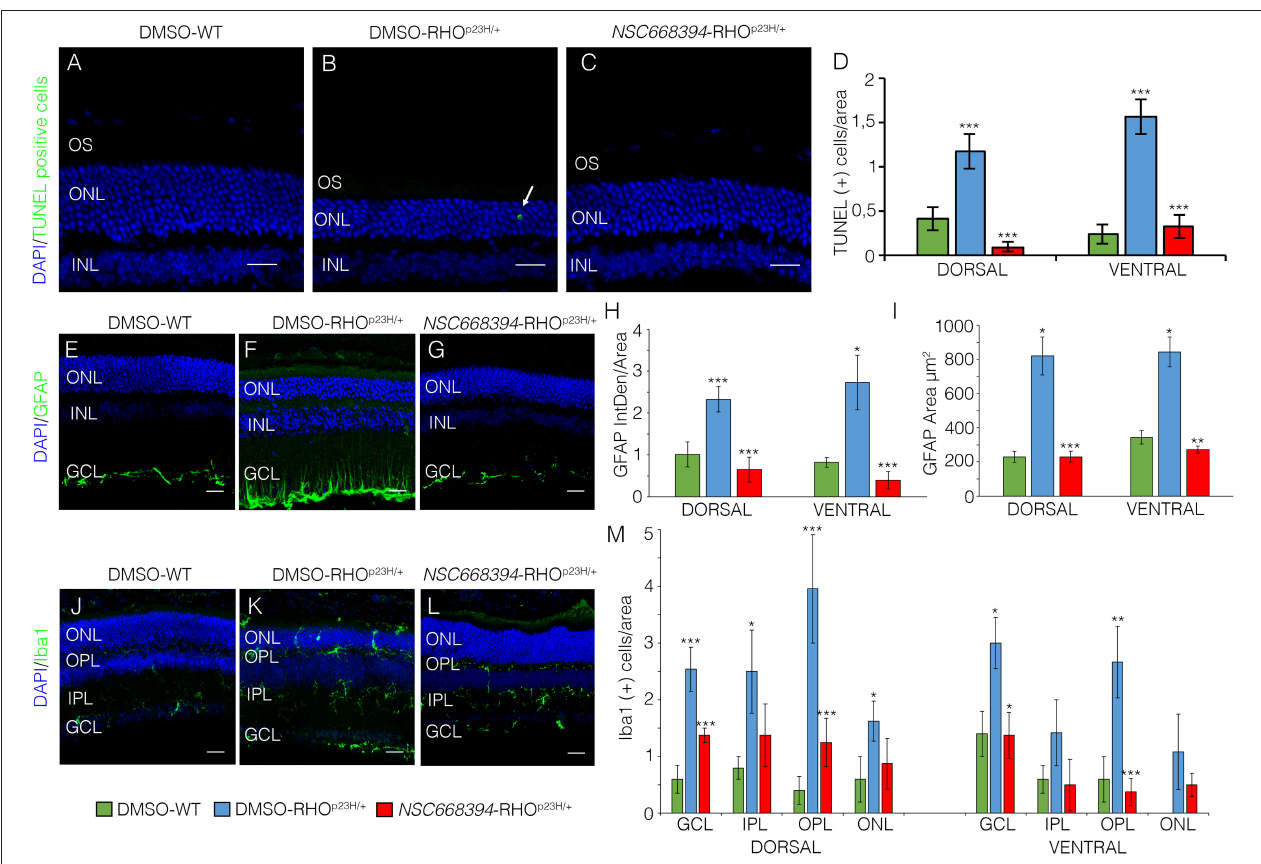
FIGURE 3 | The NSC668394 -treated RHO P23H / + mice display a reduction in retinal cell death, microglia and inflammation. Representative images of DMSO-treated WT (A) , DMSO-treated RHO P23H / + (B) and NSC668394 -treated RHO P23H / + (C) retinas of 2 months of age stained with TUNEL-fluorescein. Positive cells are indicated with white arrows. Nuclei are counterstained with DAPI (blue). At least n = 4 mice per group. Scale bar 20 µ m. (D) Graph shows the number of TUNEL positive cells from the dorsal and ventral retina of DMSO-treated WT, DMSO-treated RHO P23H / + and NSC668394 -treated RHO P23H / + mice at 2 months of age. Error bars represent SEM. Representative images of DMSO-treated WT (E) , DMSO-treated RHO P23H / + (F) and NSC668394 -treated RHO P23H / + (G) retinas of 2 months of age stained with GFAP. Nuclei are counterstained with DAPI (blue). At least n = 3 mice per group. Scale bar 20 µ m. (H) Bar graph is the quantitative analysis of optical density for GFAP fluorescence from the dorsal and ventral retina of DMSO-treated WT, DMSO-treated RHO P23H / + and NSC668394 -treated RHO P23H / + mice at 2 months of age. Error bars represent SEM. (I) Bar graph shows quantification of GFAP-immunoreactive area in the dorsal and ventral retina of DMSO-treated WT, DMSO-treated RHO P23H / + , and NSC668394 -treated RHO P23H / + mice at 2 months of age. Error bars represent SEM. Representative images of DMSO-treated WT (J) , DMSO-treated RHO P23H / + (K) , and NSC668394 -treated RHO P23H / + (L) retinas of 2 months of age stained with Iba-1. Nuclei are counterstained with DAPI (blue). At least n = 3 mice per group. Scale bar 20 µ m. (M) Bar graph represents the number of Iba-1 positive (Iba-1 + ) cells in the dorsal and ventral retinal layers of DMSO-treated WT, DMSO-treated RHO P23H / + and NSC668394 -treated RHO P23H / + mice at 2 months of age. Error bars represent SEM. OS, outer segment;